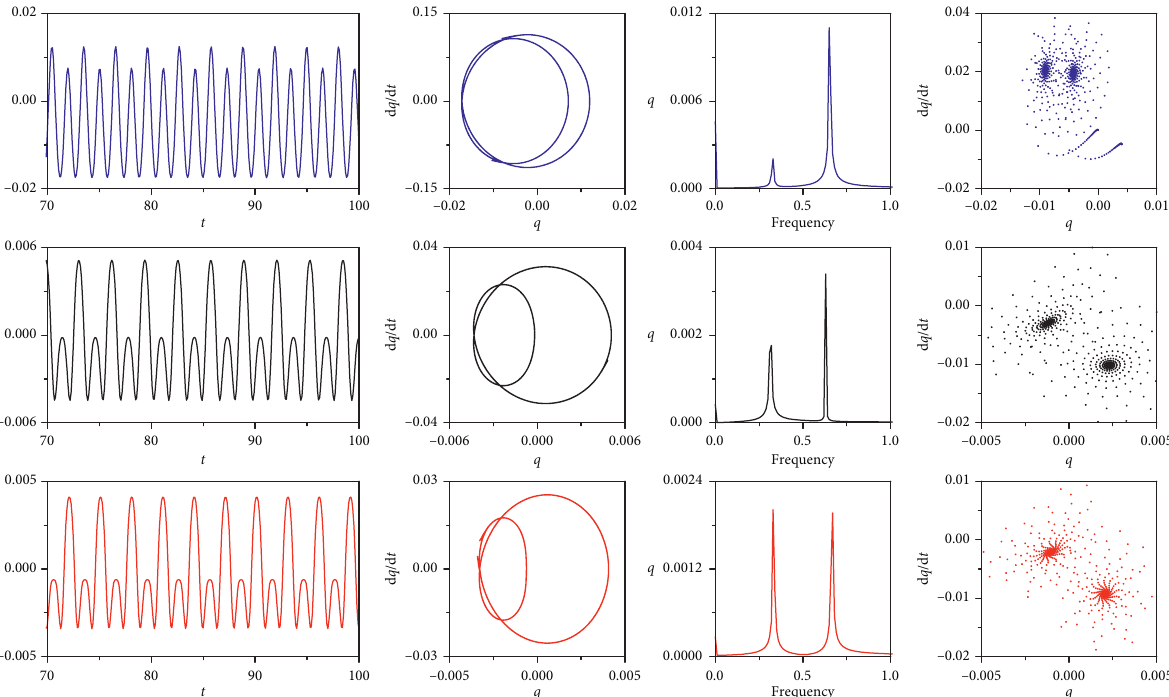
Figure 5: Temperature effects on time history curves, phase portraits, frequency spectrum, and Poincar´e sections when f � 0 . 01, σ � 0 . 05, � K � 0 . 015 in Case (B). (a) 40 ∘ C, (b) 0 ∘ C, and (c) − 40 ∘ and K 21 11